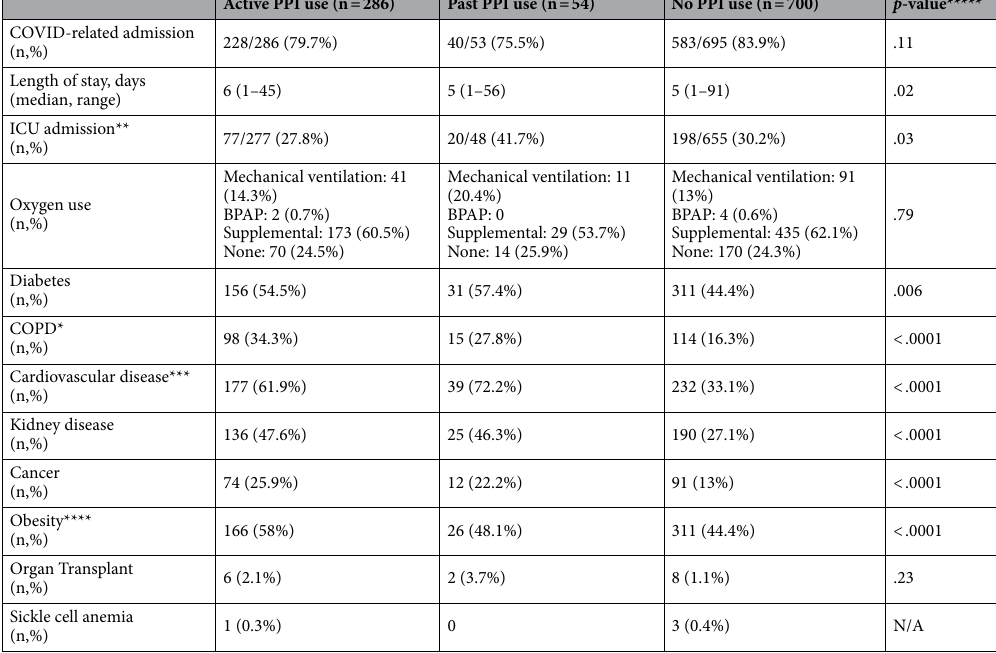
Table 4. Hospital-admitted patient outcomes based on PPI Use* (n = 1,040). * PPI Proton pump inhibitor, COPD Chronic obstructive pulmonary disease. **Denominators are reduced due to “N/A” responses for